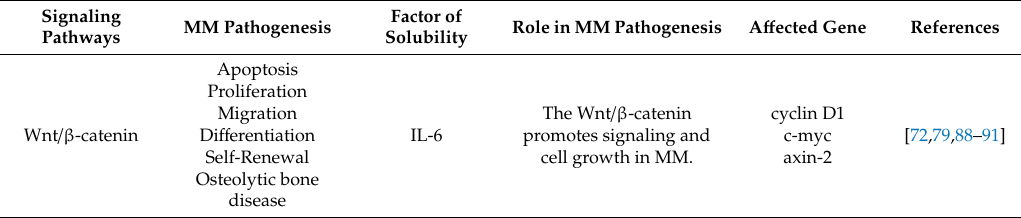
Table 1. The role of dysregulated signaling pathways in multiple myeloma (MM) pathogenesis. Signaling